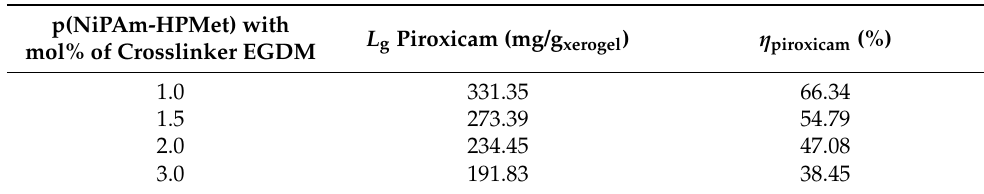
Table 8. The Mass of incorporated piroxicam ( L g ) into p(NiPAm-HPMet) samples and piroxicam incorporation efficiency ( η piroxicam ).